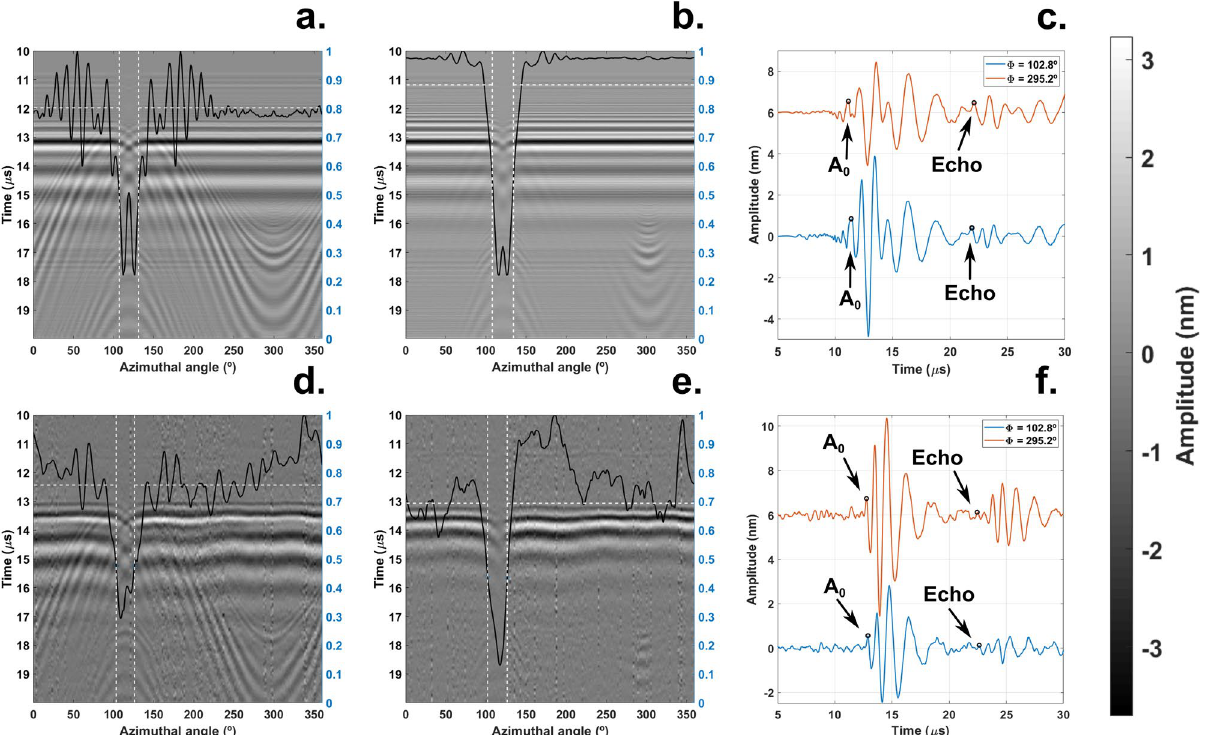
Figure 5. Detection of Lamb waves originated from the apex of the hemisphere. The acoustic maps ( a,b,d,e ) consist of 200 signals stacked next to each other where the x-axis represents the azimuthal angle, the y-axis the propagation time of the acoustic waves and the color gradient the wave amplitude. First row: Experimental results; second row: simulation results (a,d point source, b,e line source). c,f: echoes arising from a 9.5 mm defect on a laser line source scan at φ = 102.8° and its antipodal location φ = 295.2°. The black lines in ( b,e ) represent the acoustic power at different azimuths. The horizontal white lines represent its mean value across the undamaged region while the vertical lines are the −3 dB points. Data have been filtered to remove standing waves.